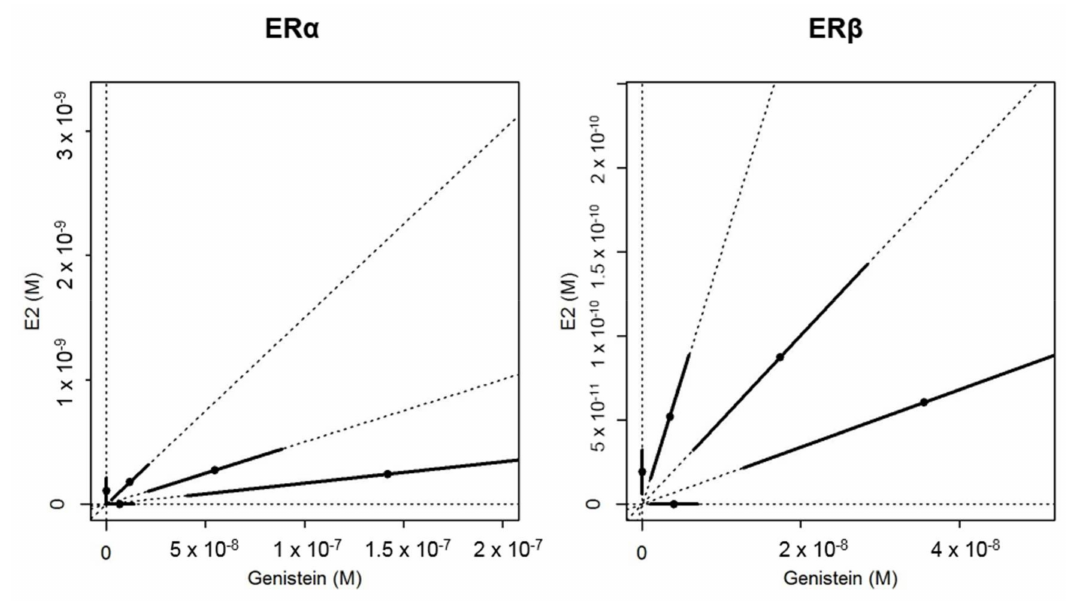
Figure 2. Illustration of the EC50 for each ray of the estradiol (E2) + genistein mixtures (EC50s isobologram). The points represent the EC50 and the bars represent the 95% confidence interval. These data originated from the in vitro assays with U251-MG cells transfected with the promoter of the zebrafish cyp19a1b gene coupled to the luciferase reporter gene and the zebrafish ERs (ER α or ER β 2). The isobole is the line formed when EC50s of each ray are joined. A straight isobole would indicate additivity. The deviation of the isobole to the right indicates an